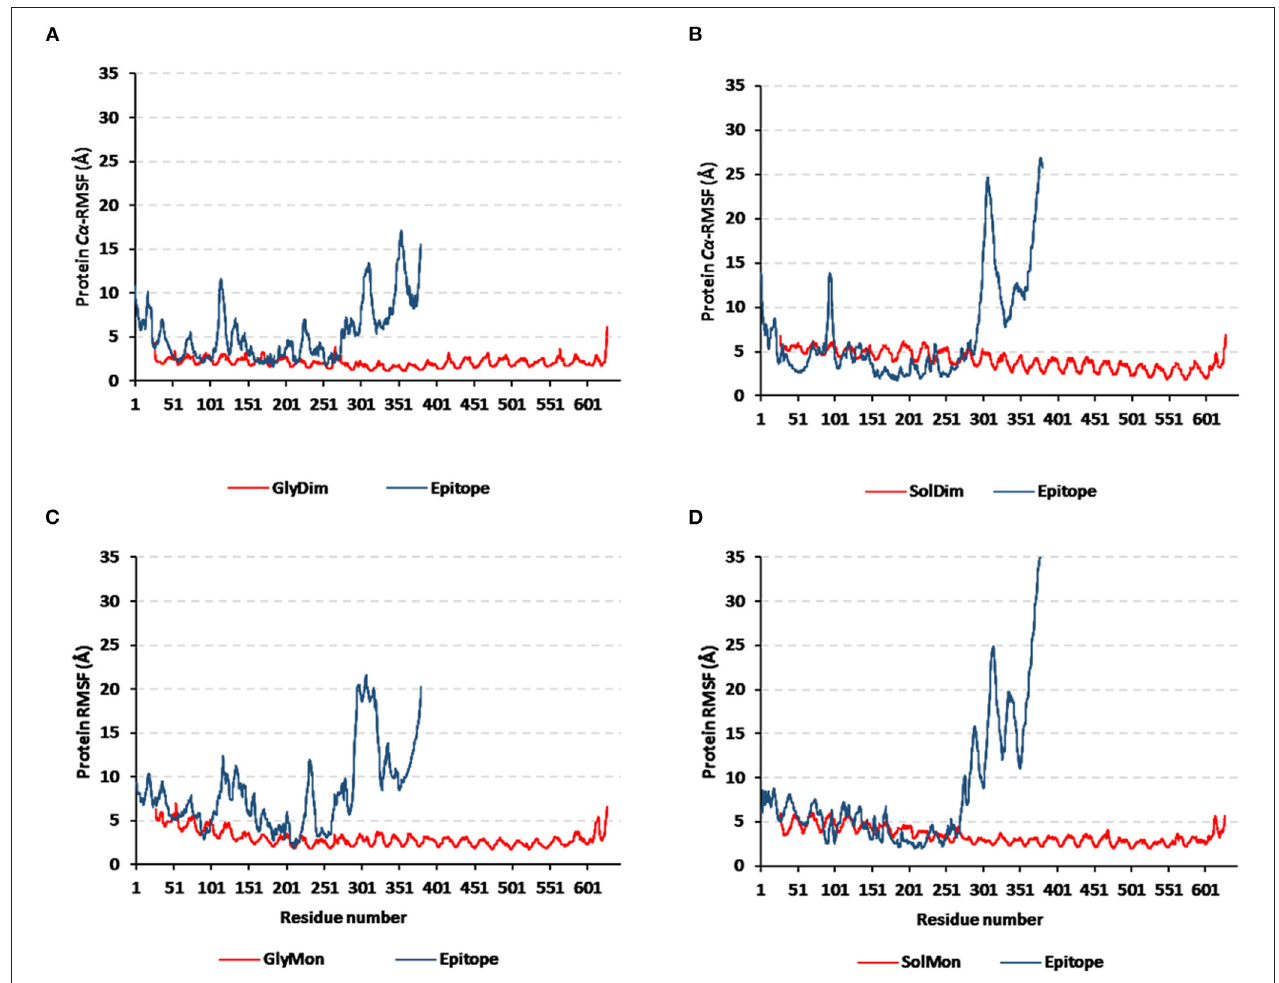
FIGURE 8 | Protein’s residue-wise fluctuation patterns. Monitored C α -RMSF tones across the whole 100 ns molecular dynamics runs for the investigated hTLR-4 bound epitope vaccine within different oligomeric/saccharide-linked states. (A) glycosylated dimeric, (B) non-glycosylated dimeric, (C) glycosylated monomeric, and (D) non-glycosylated monomeric states, along the sequence residue numbers (bound TLR-4 protein target = 27–627; epitope vaccine = 1–380 residue ranges).